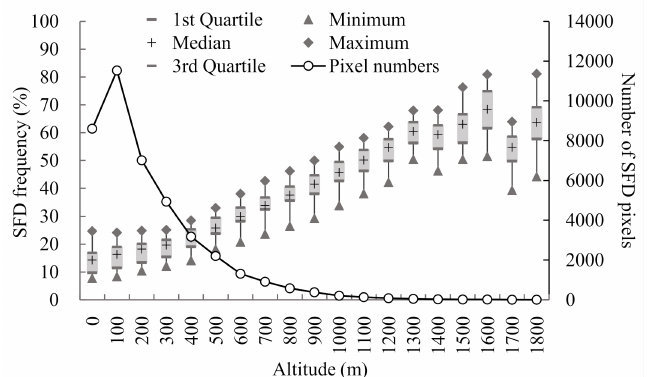
Figure 11. Annual spring frost damage (SFD) frequency (box plots, left y -axis) and number of SFD pixels (black line with open circles, right y -axis) for tea plants as influenced by altitude at 100 m intervals in 2003–2020 in the middle and lower reaches of the Yangtze River region, China. The upper and lower boundaries of the box plots represent the 25th and 75th percentiles, the black crosses are the medians, and solid triangles and diamonds at the ends of the whiskers represent the minimum and maximum frequencies,